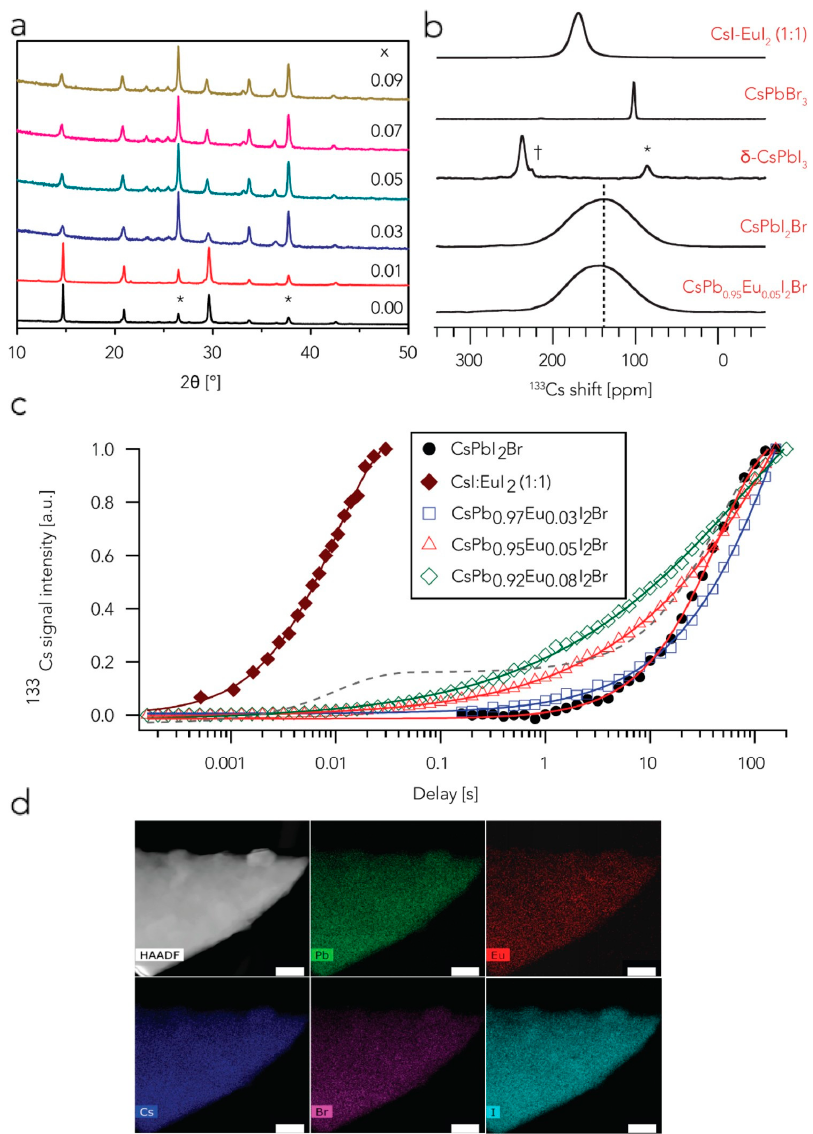
Figure 8. ( a ) XRD patterns of europium-doped CsPb 1 − x Eu x I 2 Br (0 ≤ x ≤ 0.09) perovskite thin where * denotes the peaks of fluorine ‐ doped tin oxide substrate; ( b ) 133 Cs solid state magic angle spinning (MAS) NMR spectra obtained at 11.7 T 20 kHz and temperature of 298 K; † denotes a